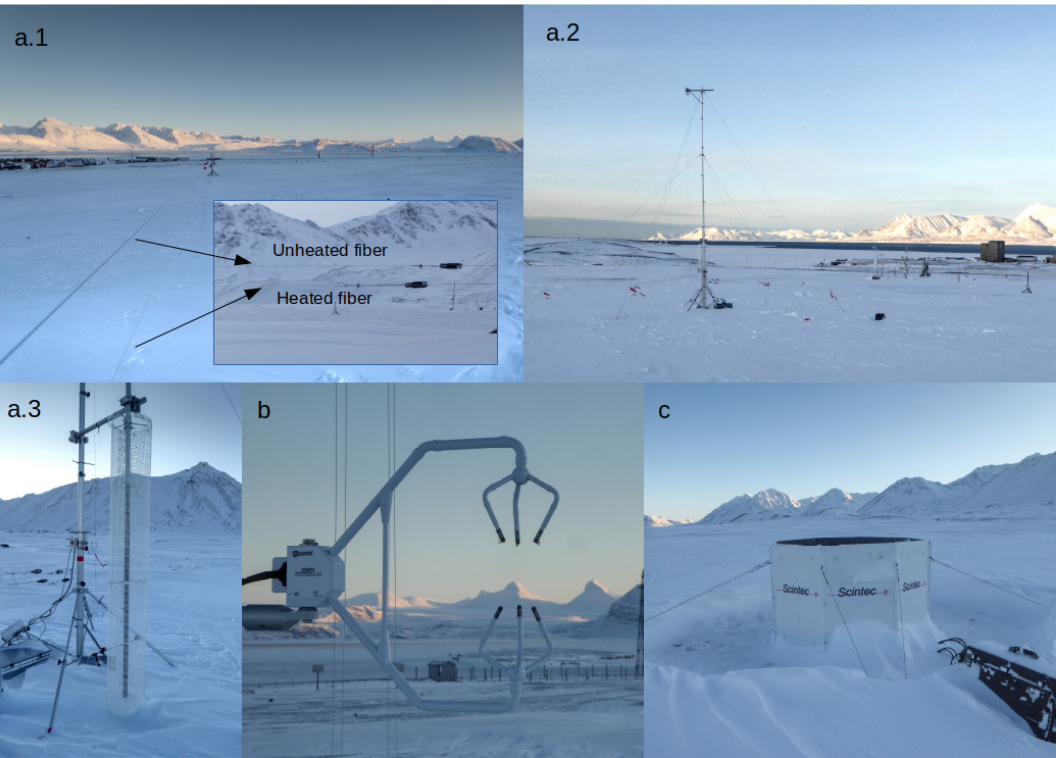
Figure 3. Main components of the NYTEFOX field setup: (a.1) fiber-optic cable (metal encased) – horizontal temperature and wind speed measurements; (a.2) fiber-optic cable (metal encased) – low-resolution vertical profiles of temperature and wind speed across 7m of height, here at the EDDY tower; (a.3) fiber-optic cable (PVC-coated) – high-resolution vertical temperature profile across the first 2.5ma.g.l. (column); (b) ultrasonic anemometer – flux densities, wind direction, and wind speed measurements at the towers, here at the BSRN tower; (c) acoustic profiler (minisodar) – wind measurements located near the EDDY tower.